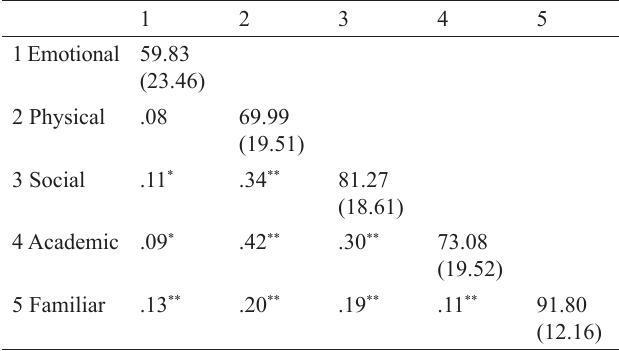
Table 3. Pearson correlations and descriptors for dimensions of the AF5